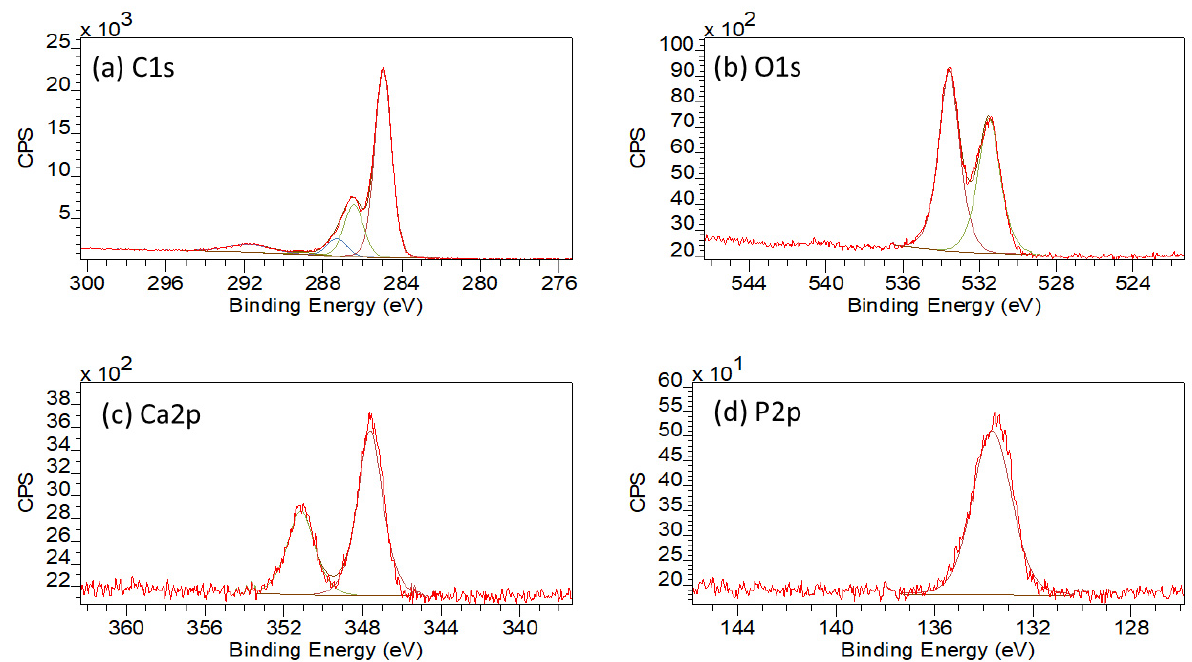
Figure 7. XPS high resolution scans for 30HA where ( a ) C1s, ( b ) O1s, ( c ) Ca2p, and ( d )